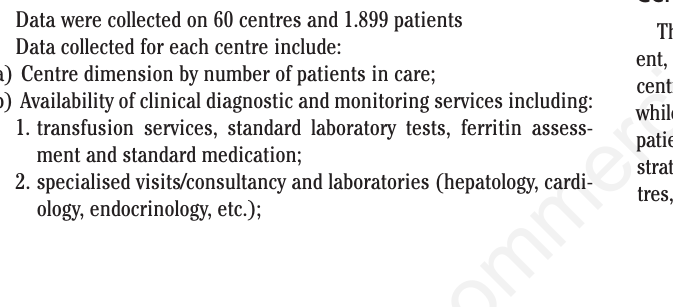
Table 2. Italian clinical care centres for thalassaemic patients distributed by Region and patients in the Registry (April 2011). Italian Region Centres identified in